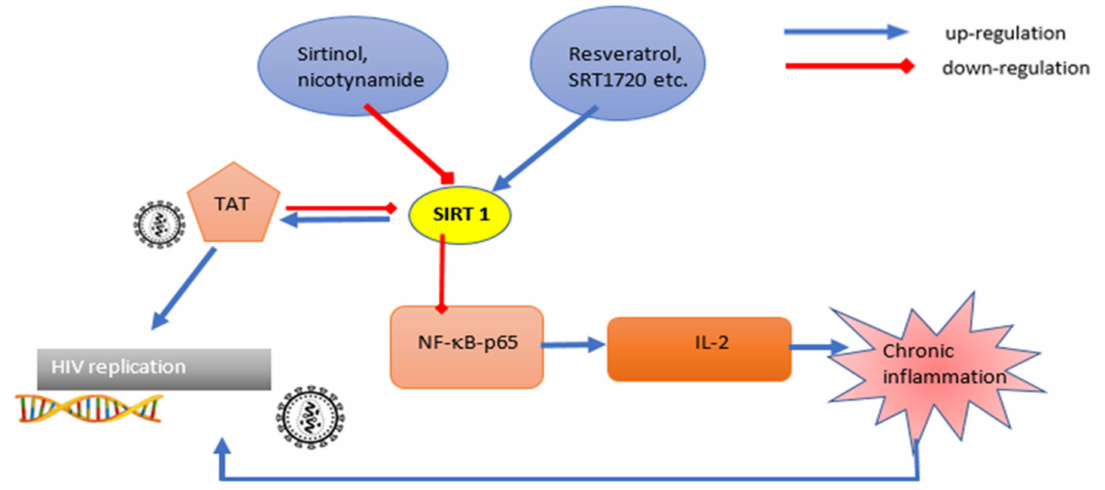
Figure 1. Scheme of interaction of SIRT1 1 with viral protein Tat [12]. Deacetylation of Tat by SIRT1 causes its reconstitution, preventing the termination of the transcription process at the elongation stage, starting the next HIV transcription cycle. Tat also directly affects SIRT1 by binding to its catalytic domain and thereby blocking deacetylase activity relative to NF-kB, causing production of transcription factors and pro-inflammatory interleukins, among others: IL-2, and as a result, HIV- specific status of chronic immune activation, which allows to integrate the newly formed viral DNA into the host genome. SIRT 1, sirtuin1; IL-2, interleukin 2; Tat, trans-sctivator of transcription; NF- κ B, nuclear factor kappa-light-chain-enhancer of activated B